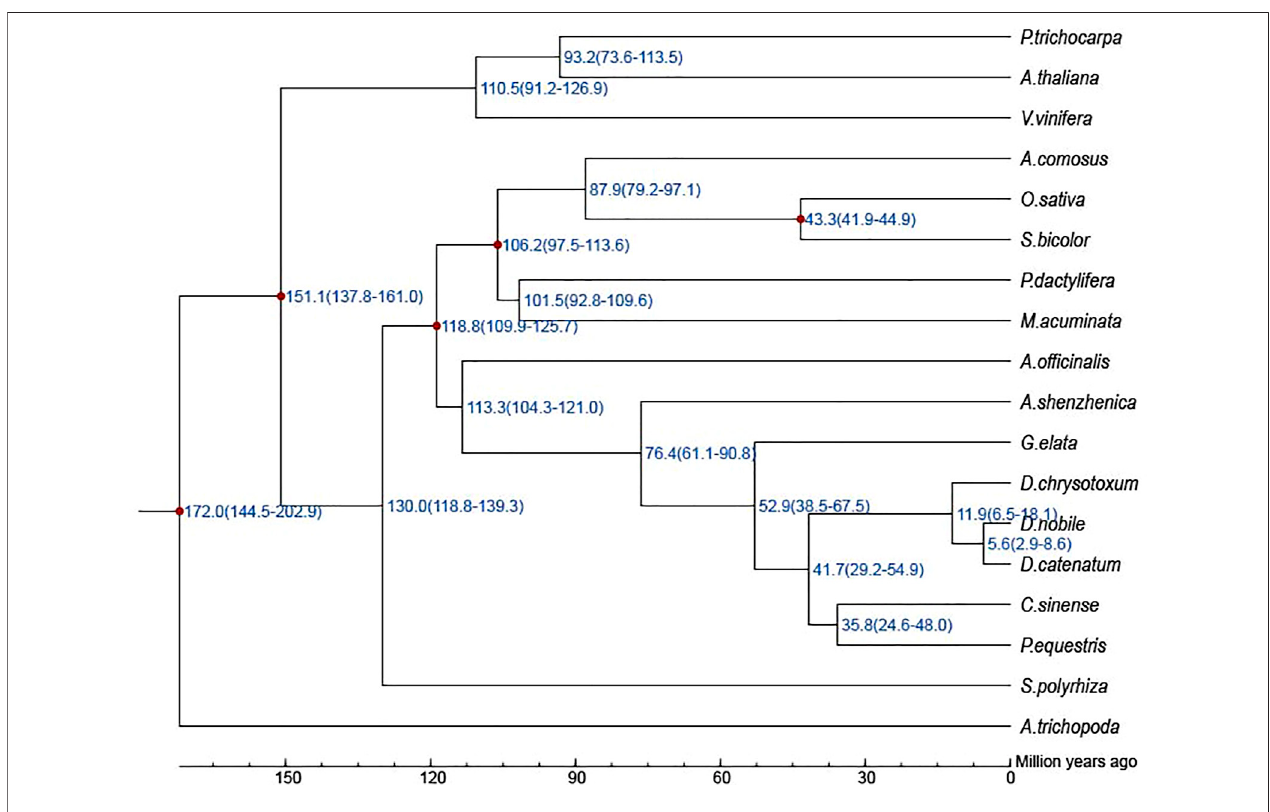
FIGURE 4 | Divergence time among 19